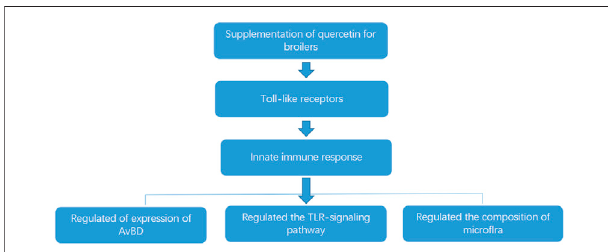
FIGURE4| The potentialmechanism ofquercetin onthe morality rateof